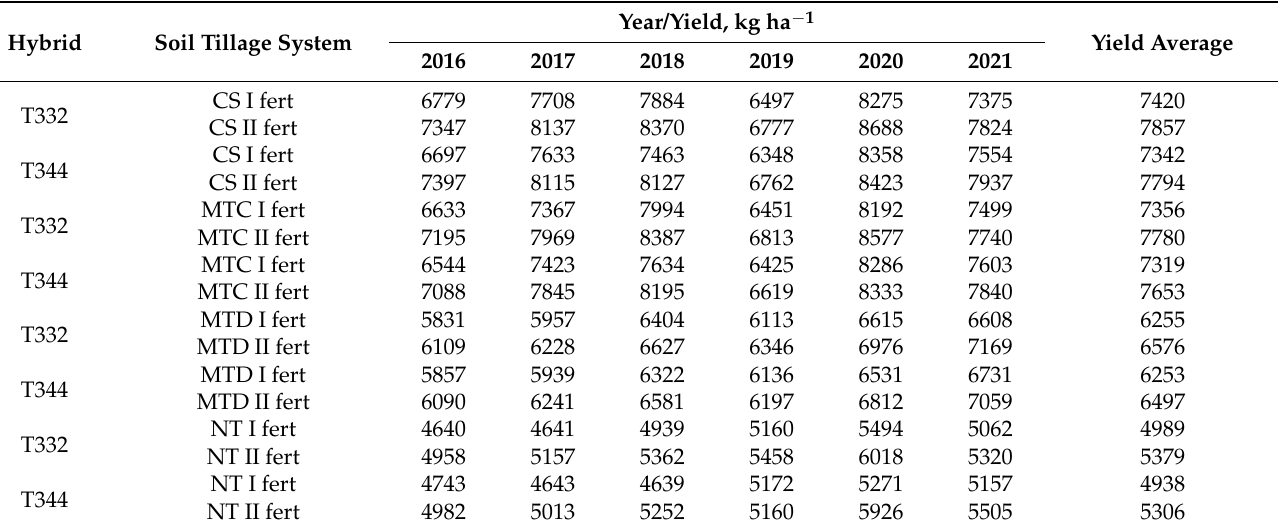
Table 9. Yield obtained at Turda when favorable conditions are met,